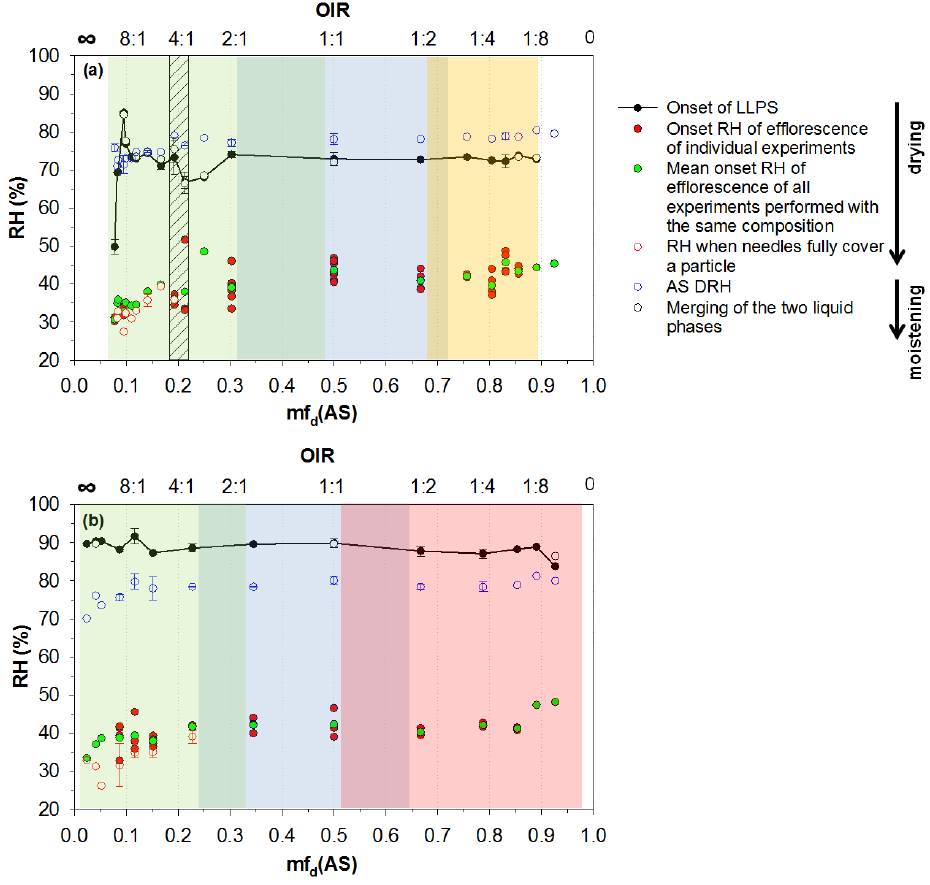
Fig. 4. Phase diagrams of (a) C6/AS/H 2 O and (b) C7/AS/H 2 O from humidity cycles. Black filled circles: LLPS onset. Red filled circles: efflorescence onset (mean values in green). Red open circles: completion of efflorescence. Blue open circles: AS deliquescence upon moist- ening. Black open circles: merging of the two liquid phases upon moistening. Background shadings represent different LLPS mechanisms upon drying: nucleation-and-growth (green), spinodal decomposition (blue), growth of a second phase at the surface of the particle (pink) and mechanism unclear (orange). Hatched area in (a) : inconstant LLPS varying among different particles in the range of 0.19 < mf d (AS) < 0.21. Error bars: standard deviation of experiments with different